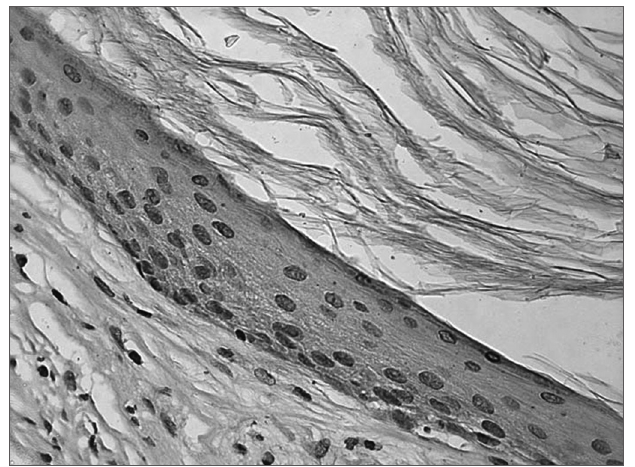
Figure 3. Microphotography of the cholesteatoma fragment where we see a severe reaction against the TNF-R2 antibody in the cytoplasm of matrix keratinocytes (IHQ